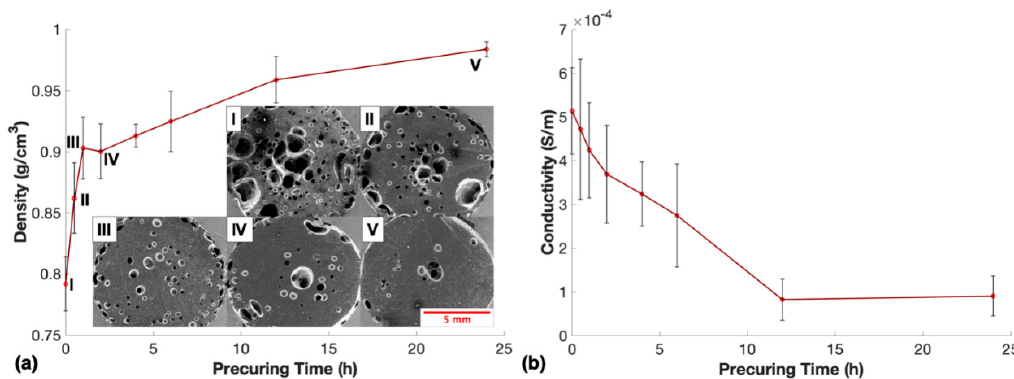
Figure 3. ( a ) Change of density and ( b ) electrical conductivity due to precuring time at room temperature for nanocomposites with 1.0 wt. % MWCNTs and scanning electron microscope (SEM) images of porosity in samples when cured: (i) immediately, (ii) with 30-min precuring, (iii) with 1-h precuring, (iv) with 2-h precuring, and (v) with 24-h precuring.